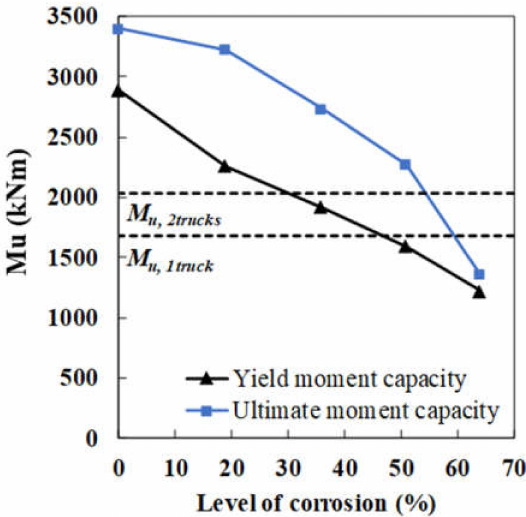
Figure 11. Yield and ultimate moment capacity versus the various level of